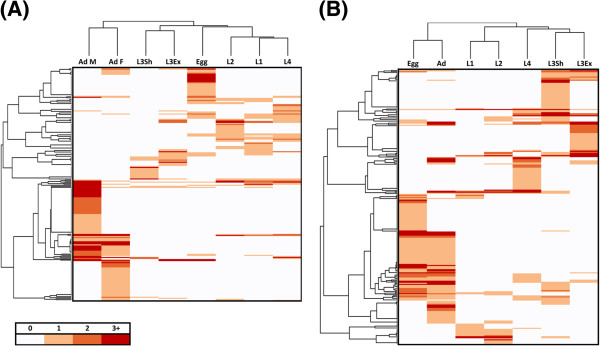
Clustering of stages based upon the number of transcripts in a stage containing a specific InterPro domain. (A) C. oncophora; (B) O.ostertagi. A lower-range scale (0 to 3+) was used to better illustrate the similarities and differences between the stages.